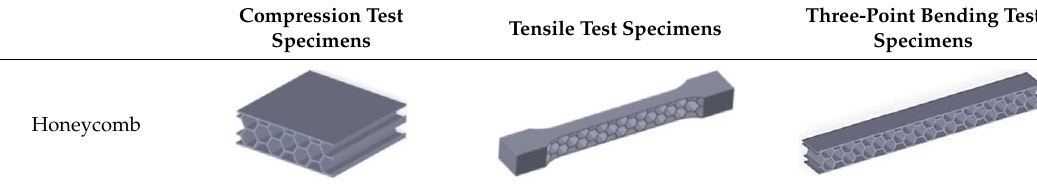
Figure 1. Specimens characteristics (dimensions in mm): ( a ) honeycomb core; ( b ) diamond-celled core; ( c ) corrugated core; ( d ) tensile specimens’ dimensions. Table 1. The proposed lightweight sandwich specimens.